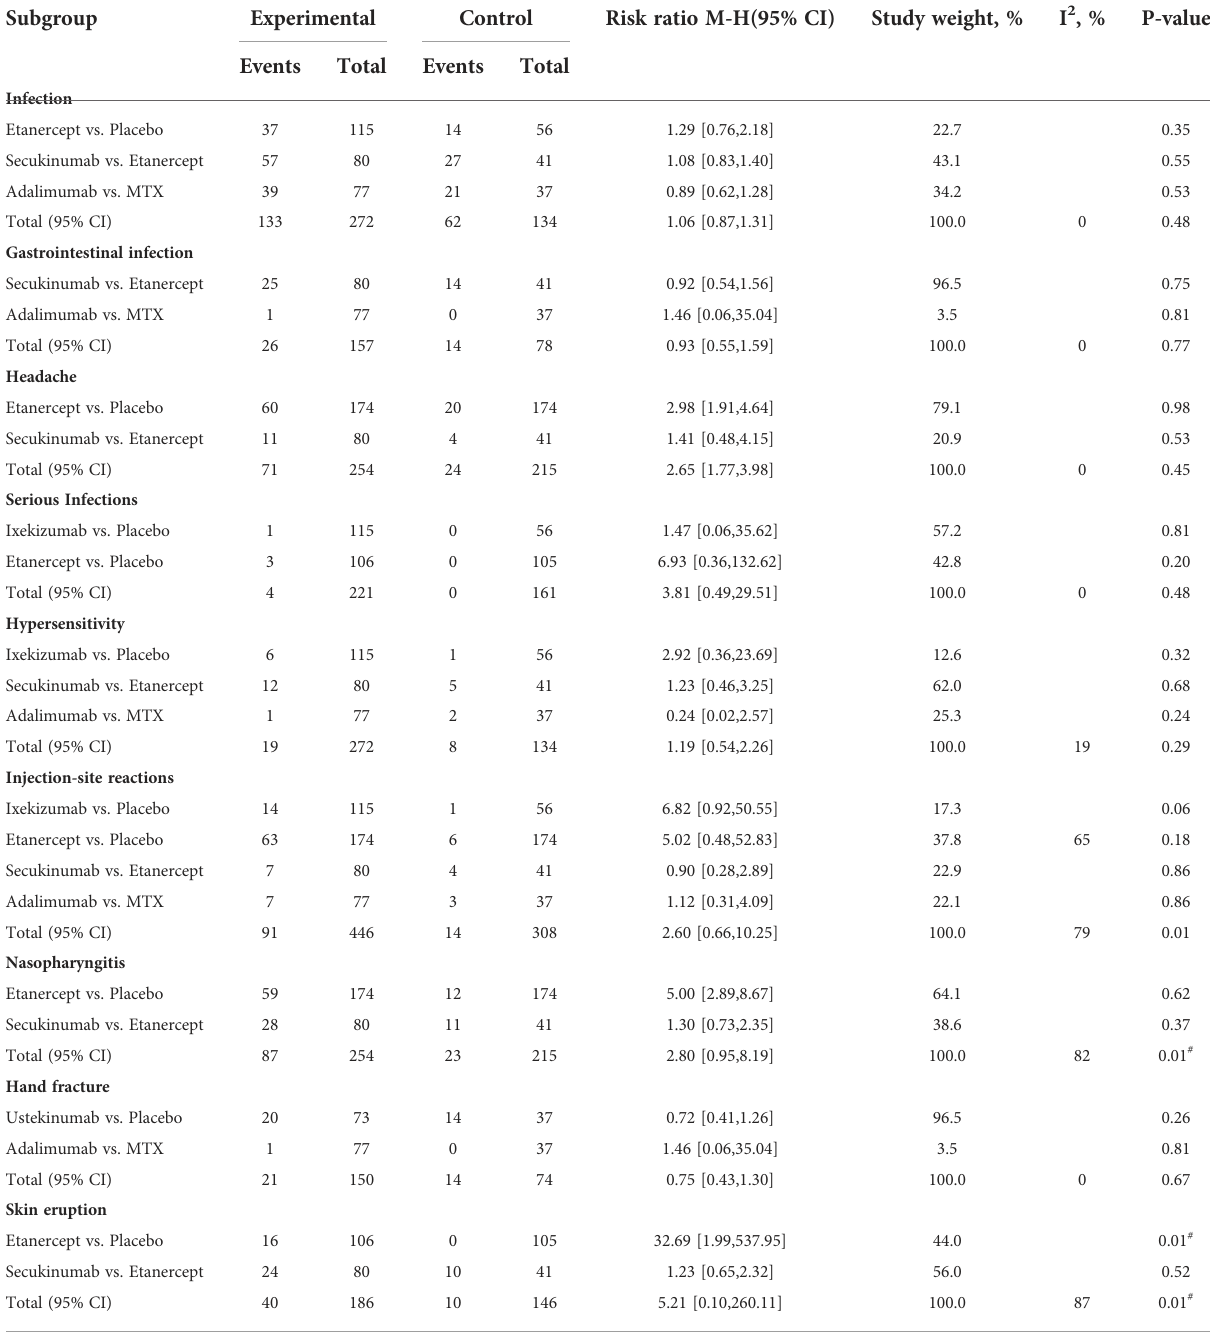
TABLE 4 Speci fi c adverse events reported on using biological agents in pediatric patients with